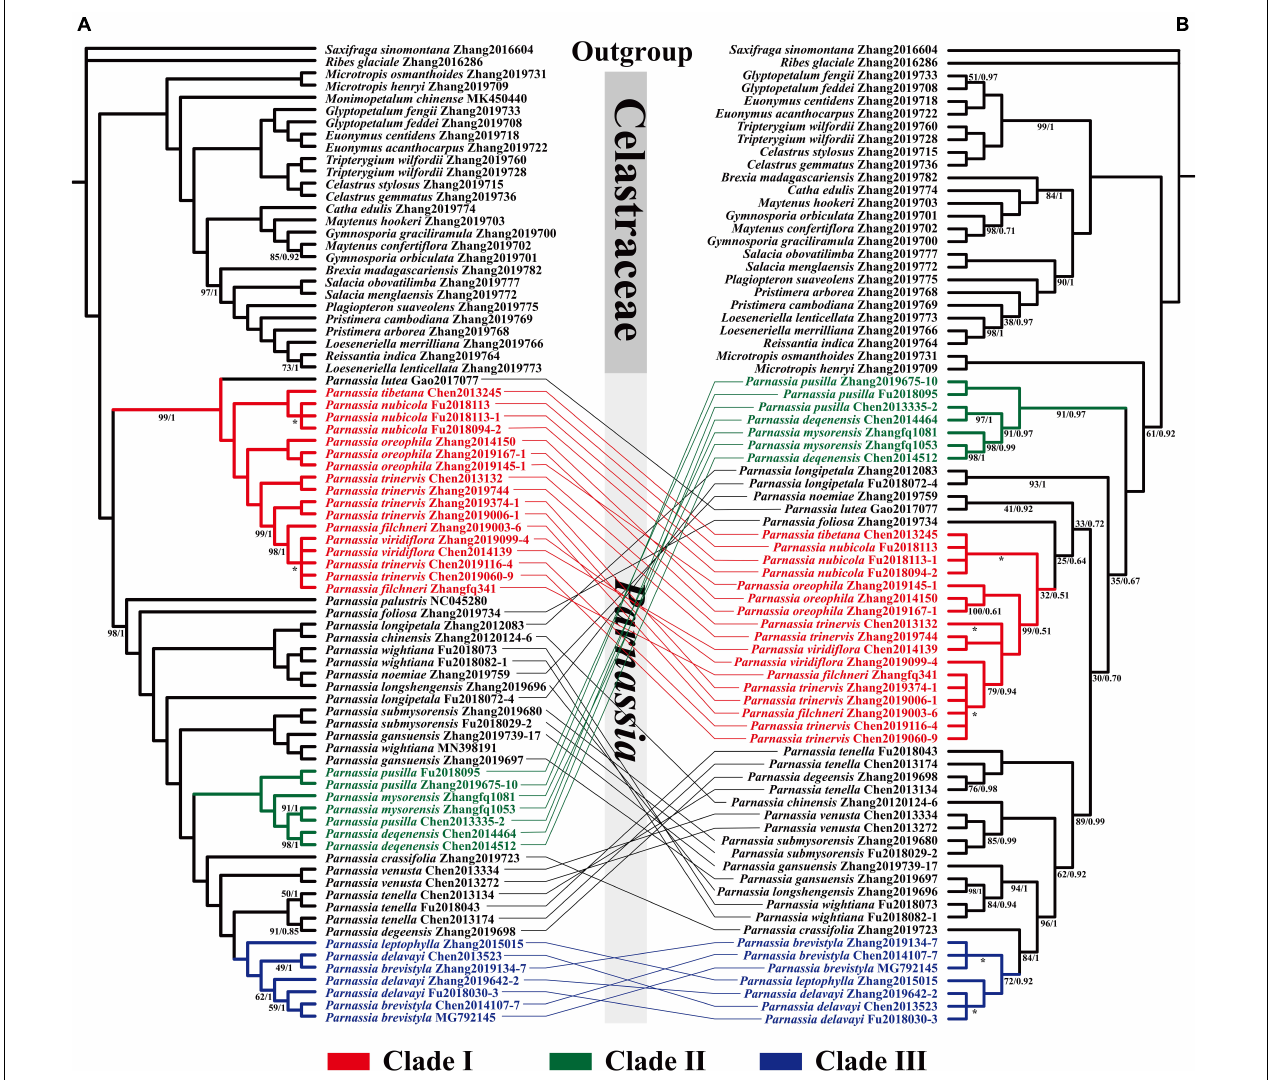
FIGURE 2 | Phylogenetic relationship of Parnassia resolved based on 73 CDSs concatenated genes (A) and nrDNA marker (B) . Numbers associated with branches are ML bootstrap values and Bayesian posterior probabilities. Nodes without numbers indicate 100% bootstrap support and 1.0 posterior probability. Nodes with * indicate that the topological structure of ML tree and BI tree is inconsistent at this